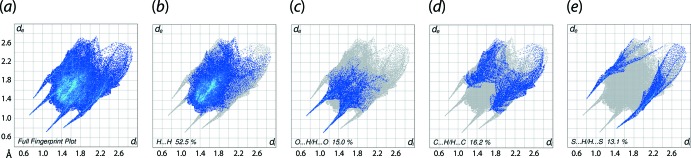
(a) A comparison of the full two-dimensional fingerprint plot for (I) and those delineated into (b) H⋯H, (c) O⋯H/H⋯O, (d) C⋯H/H⋯C and (e) S⋯H/H⋯S contacts.